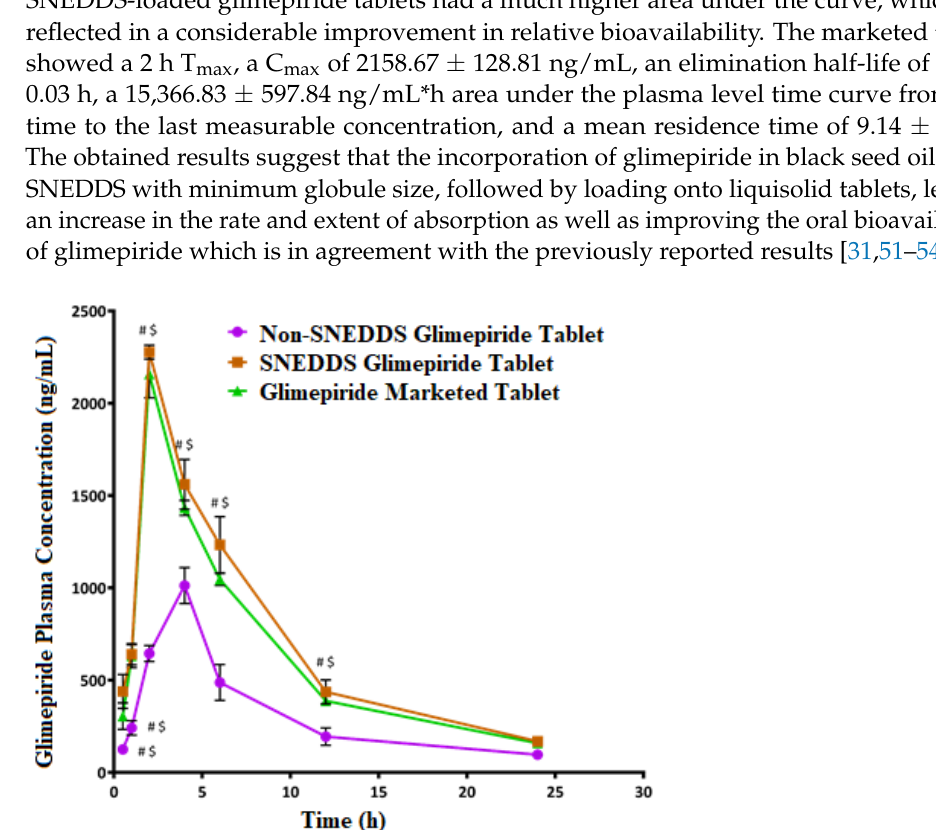
Table 7. Pharmacokinetic parameters of glimepiride after oral administration of 10 mg/kg in rats ( n = 6, the data expressed as mean ± SD).